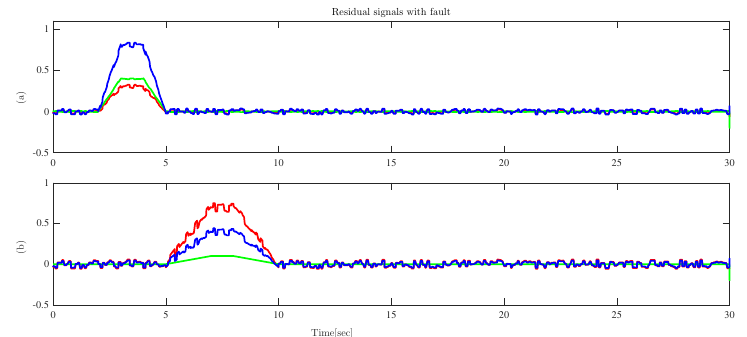
Figure 10. ( a ) Fault signal for Mode 1. ( b ) Fault signal for Mode 2.